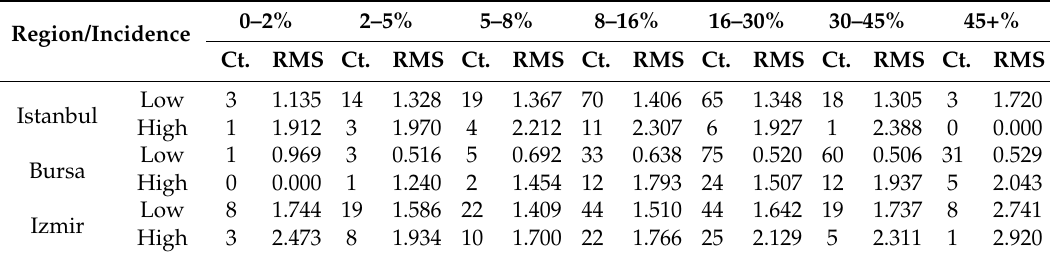
Table 3. Distribution of the number of GCPs and mean RMSEs (m) for different slope groups in the study regions (Ct.: GCP Count).